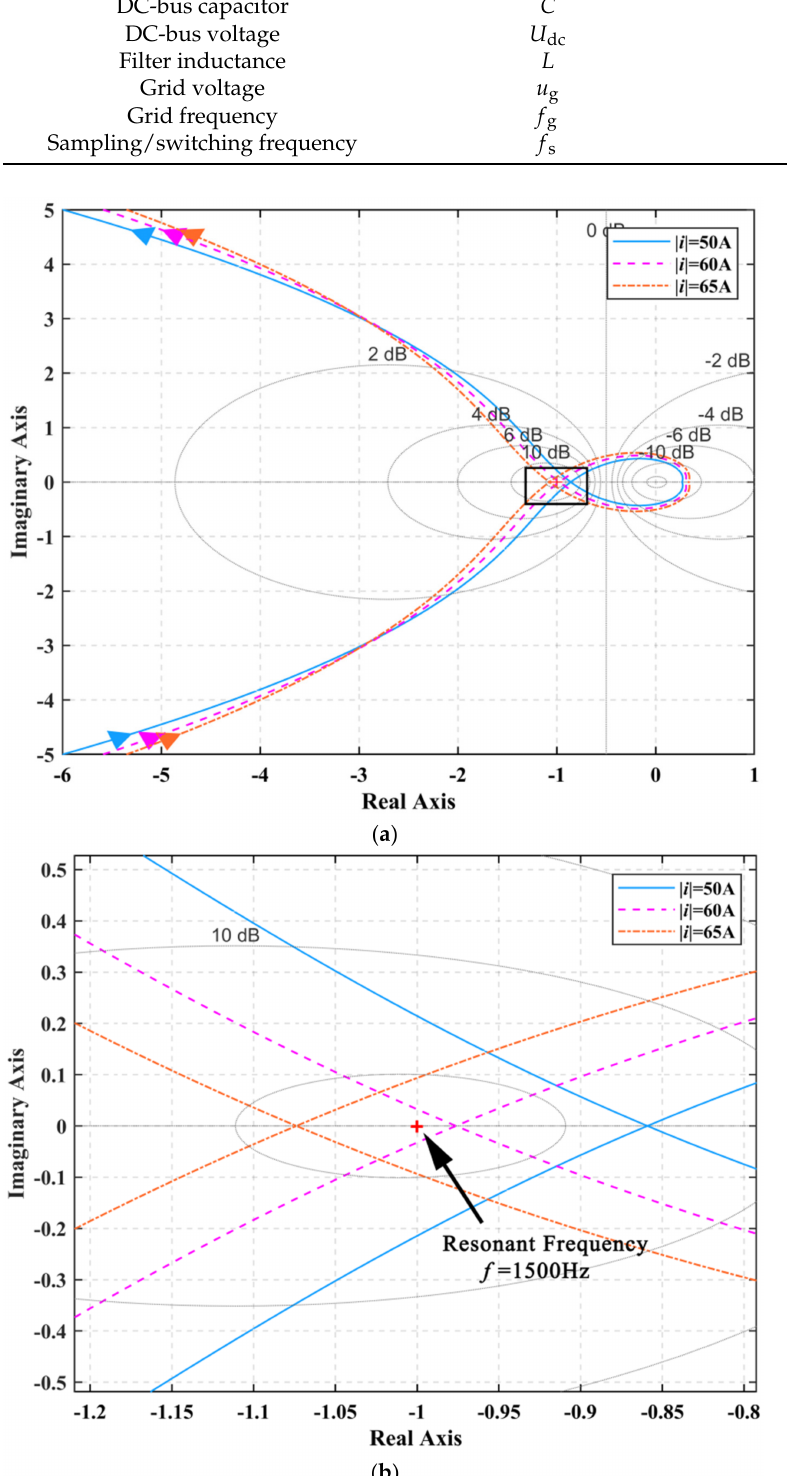
Figure 3. Stability evaluation of the GcC with different current absolute values: ( a ) overall view of the Nyquist curves when the current absolute value varies; ( b ) enlarged views with different current absolute